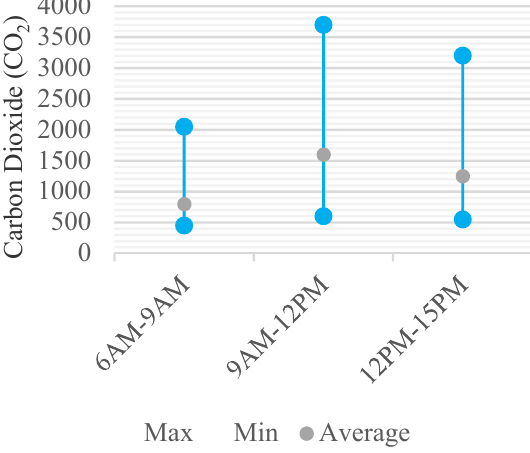
Figure 8. Daily Concentration Change of CO 2 . Figure 9. Daily concentration change of TSP.